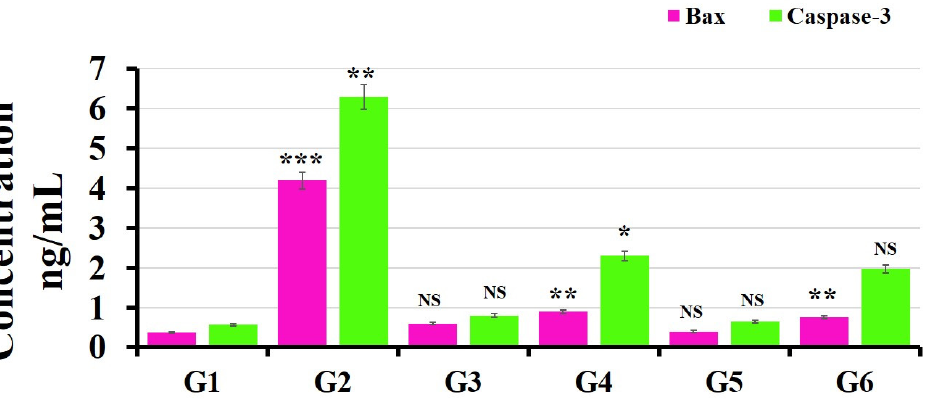
Figure 8. Effect of both MOLE and Encap. MOLE on the levels of Caspase-3 and Bax in liver tissues of BPA—Exposed versus normal rats. G1: control. G2: BPA. G3: MOLE. G4: MOLE-BPA. G5: Encap. MOLE. G6: Encap. MOLE-BPA. The data are shown as * p < 0.05 ** p < 0.01 and *** p < 0.001.